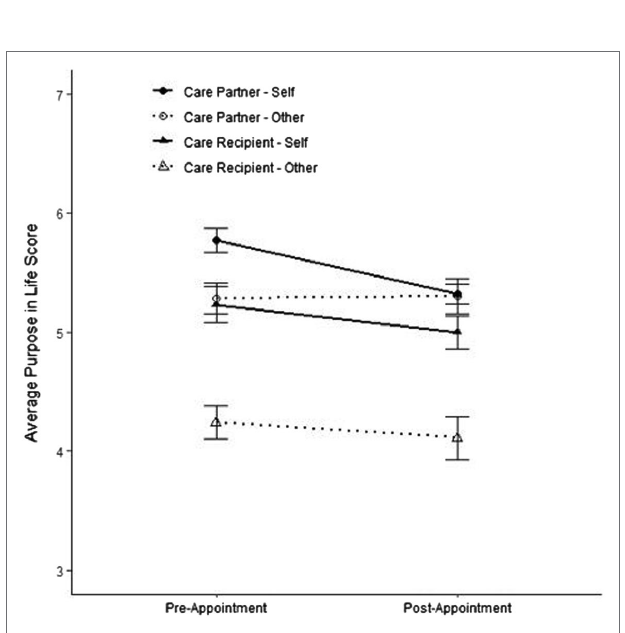
FIGURE 2 | Comparisons of self- and other-reports of purpose for care partners and care